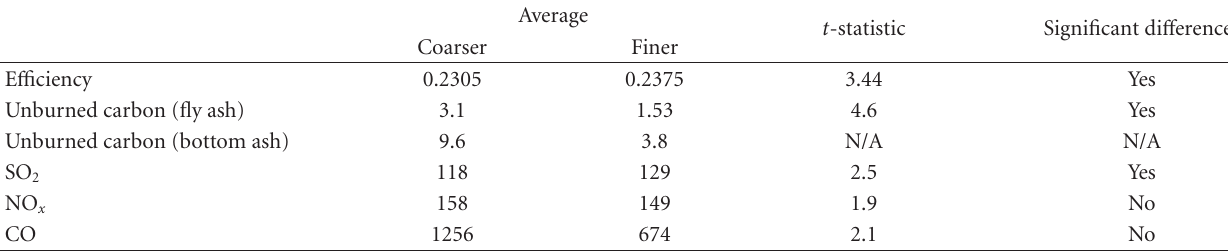
Table 8: Di ff erence in results between the two groups of tests.